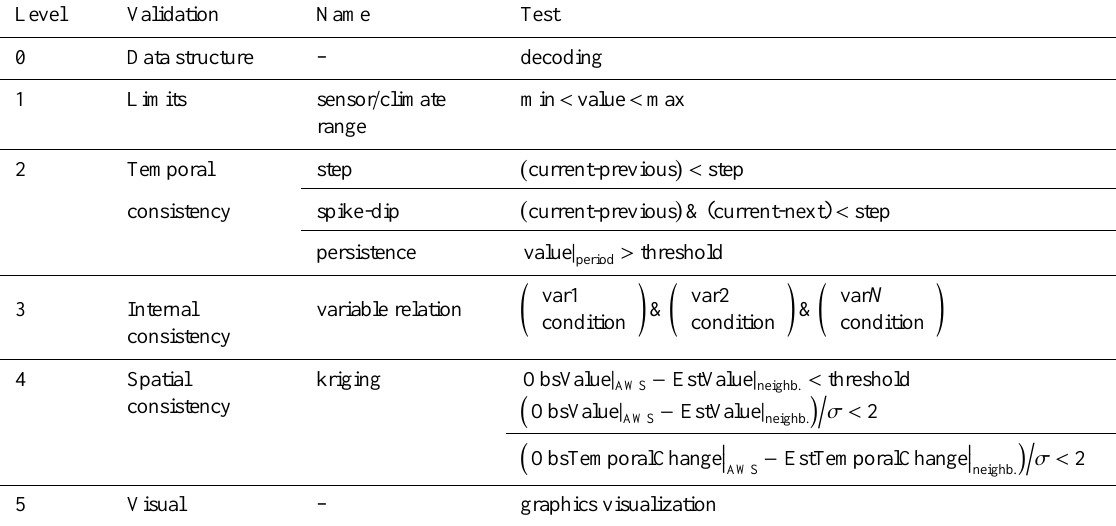
Table 3. Validation